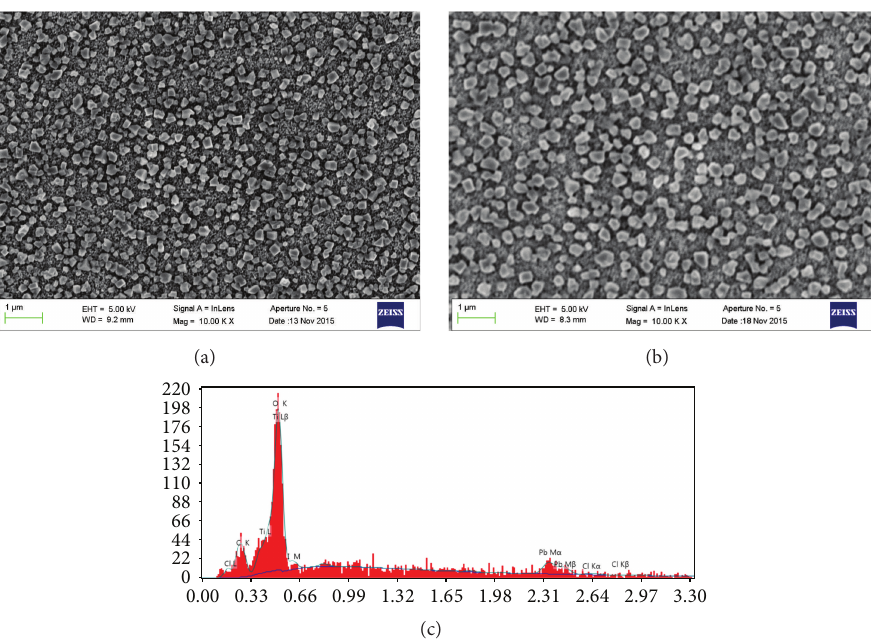
Figure 3: Top-view SEM images of the perovskite films without (a) and with (b) doping Cl − . (c) EDS pattern of the perovskite based on doping Cl −